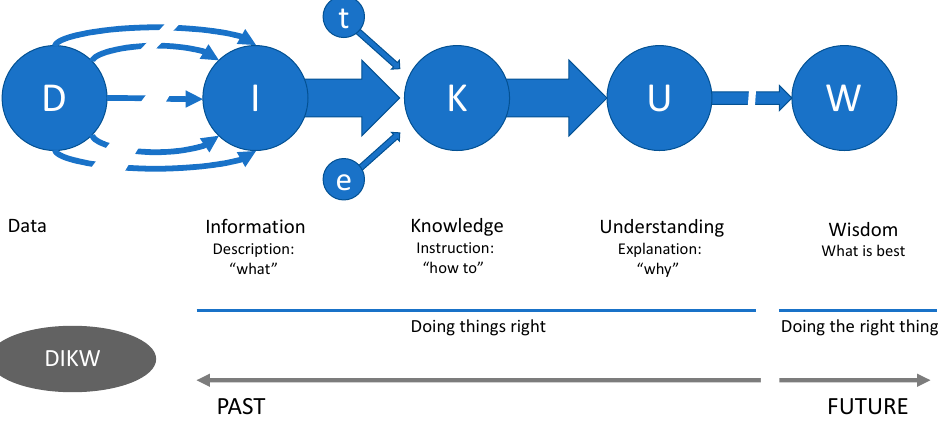
Figure 2. Transformation of data to wisdom and in doing so codifying the business processes (La Longa et al. [60]).